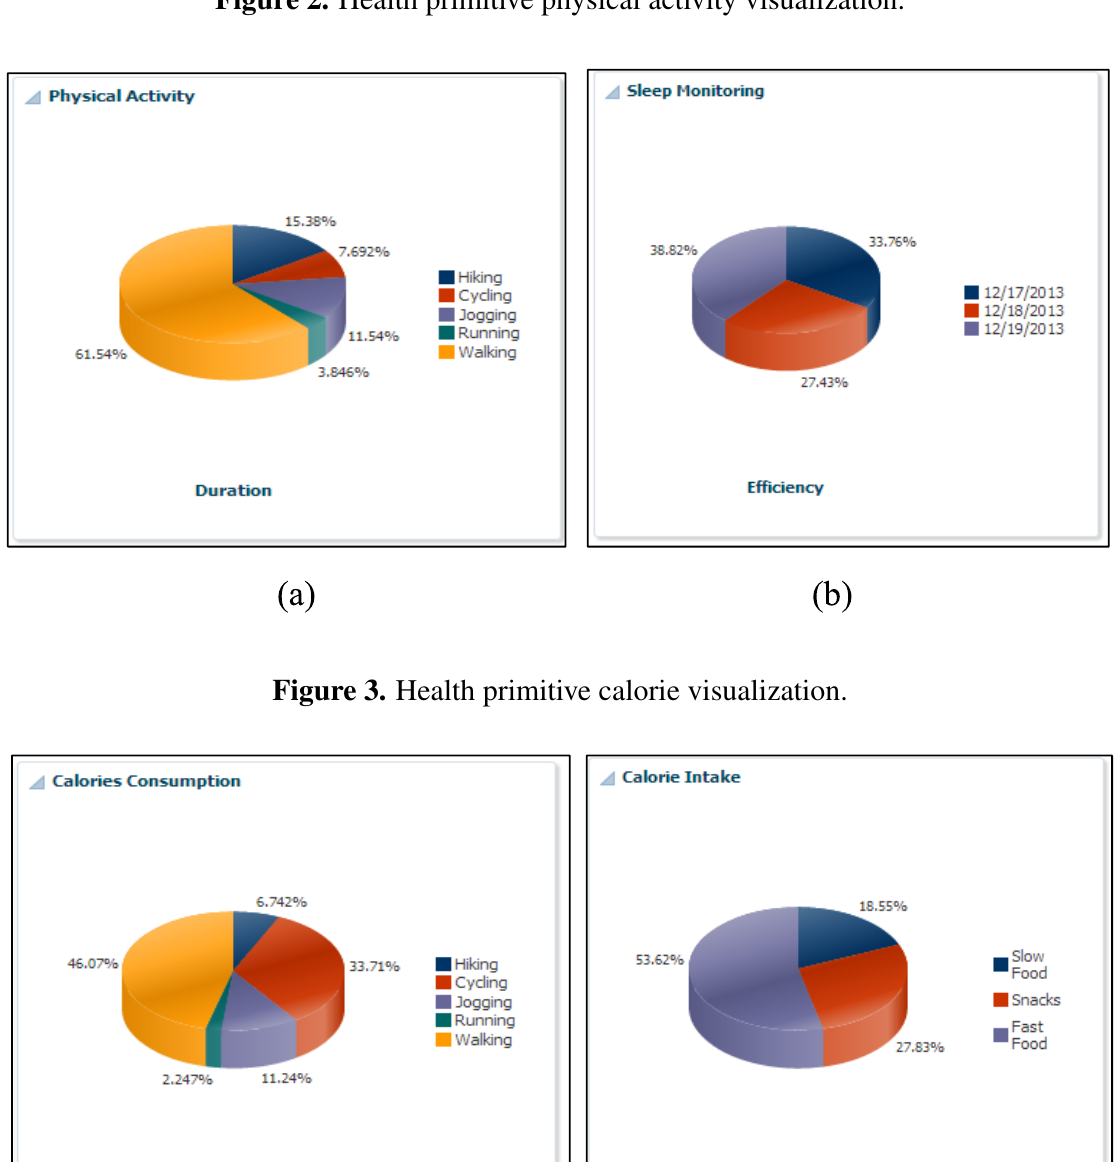
Figure 2. Health primitive physical activity visualization.